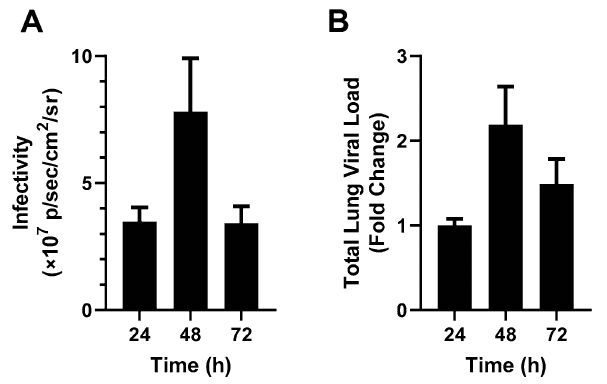
Figure 3. Time course of infectivity after inoculation of the pseudotyped virus. ( A ) Time course of luminescence levels after inoculation of SARS-CoV-2pv (n = 3, each). Data are expressed as the mean of sum luminescence of the front and back. ( B ) Time course of viral loads in lungs (n = 3, each). Data are expressed as the fold change from the higher